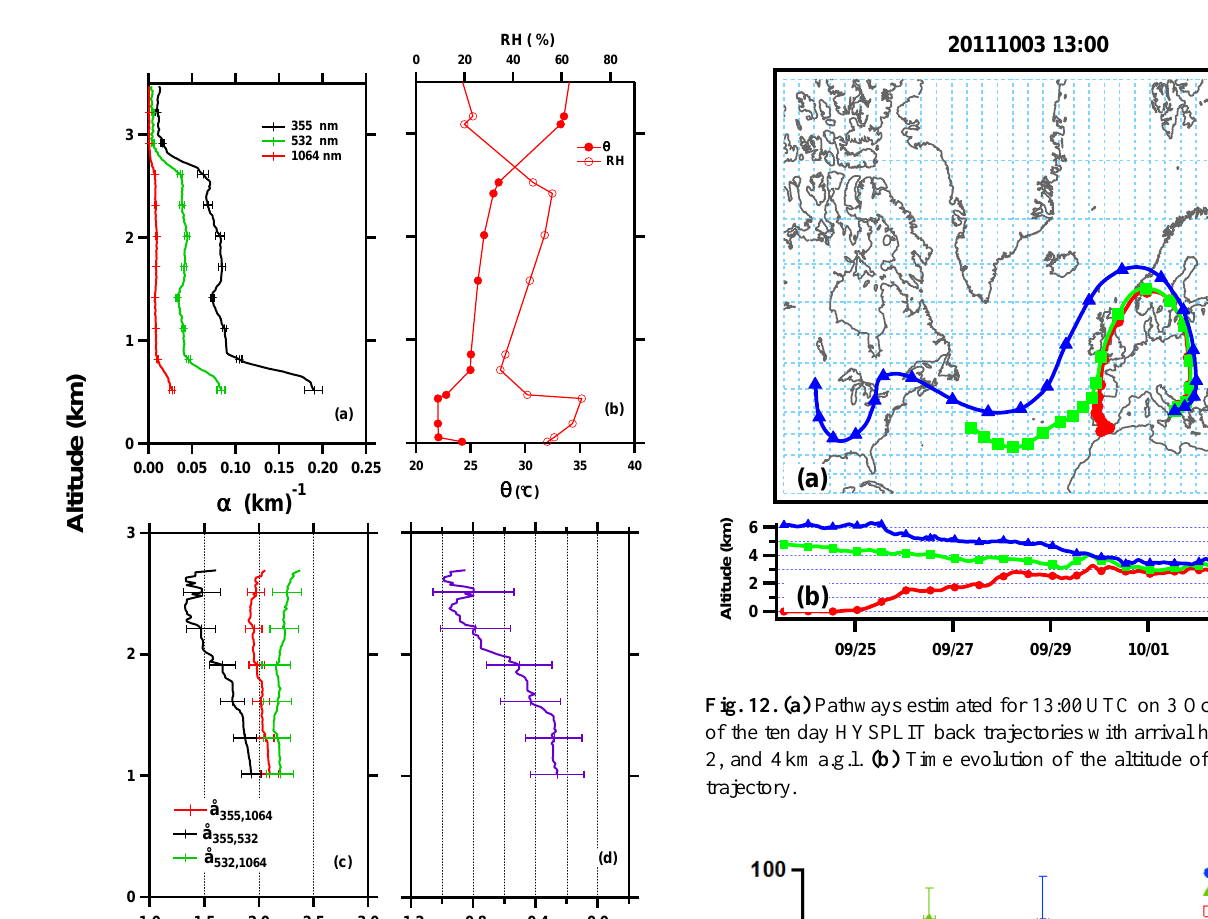
Figure 12 (M. R. Perrone et al.) 6